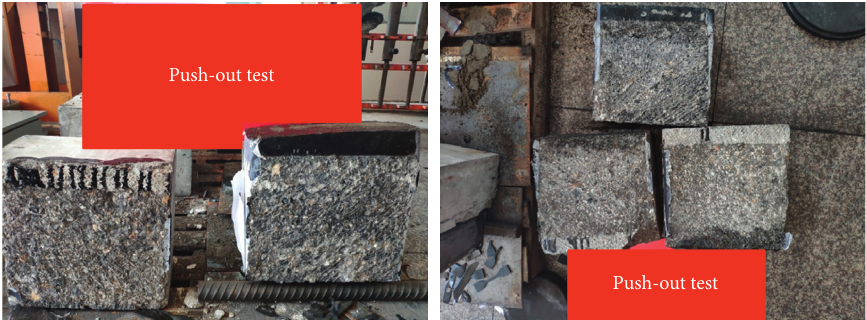
Figure 6: The failure mode of the push-out test